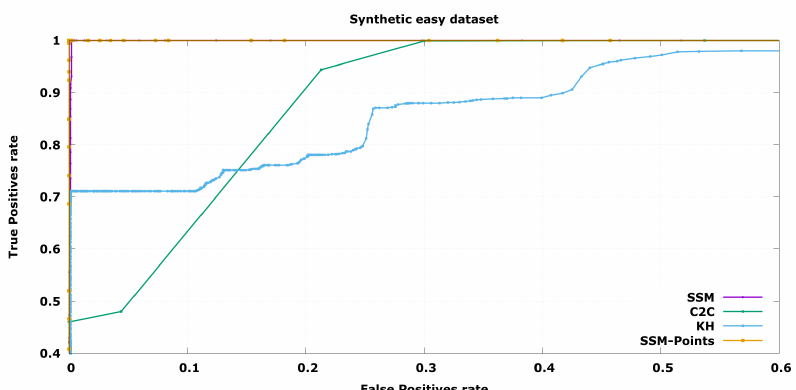
Figure 6. ROC curve for synthetic object classification from the Good and Incorrect validation sets synthetically